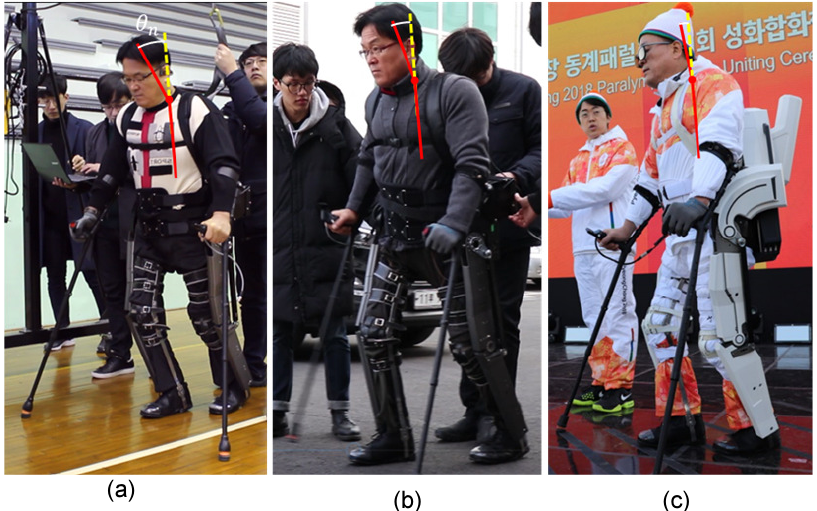
Figure 10. A pilot training for wearing the WalkON Suit with the proposed UI: ( a ) the early stage of training (the first week of training), ( b ) the middle stage of training and ( c ) the final stage of training (the fourth week of